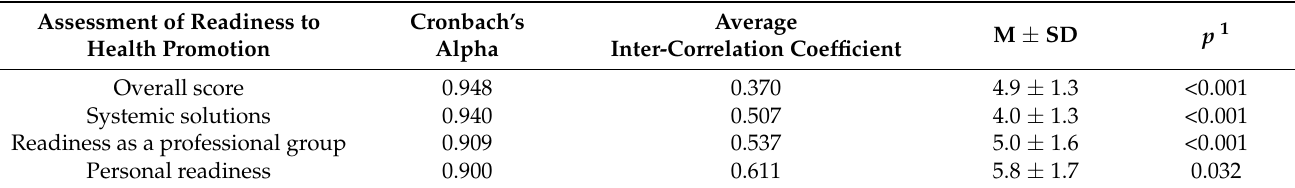
Table 1. Pharmacy students’ readiness to promote health—overall score, systemic solutions, readiness as a professional group, personal readiness (N =